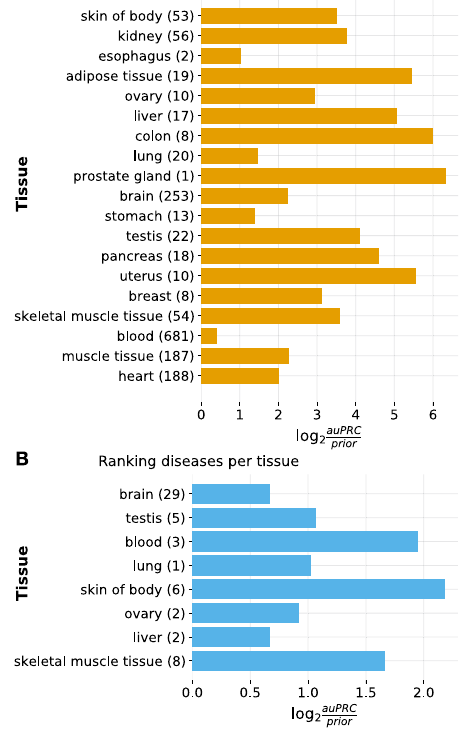
Fig. 5 | NLP-ML models can correctly classify tissue-associated biological pro- cessesanddiseasesbasedontheirtextdescriptions.A Modelperformancesona set of manually curated tissue-speci fi c Gene Ontology biological process (GOBP) terms 30 . B Modelperformancesonasetofmanuallycuratedtissue-speci fi cDisease Ontologyterms 30 .Inbothpanels,Themodelsareindicatedalongthe y -axiswiththe number of annotated GOBP/DO terms in parentheses next to the tissue name. Performance is shown on the x -axis using the logarithm of the area under the precision-recall curve (auPRC) over the prior, where the prior is the fraction of all GOBP/DOtermsspeci fi ctoaparticulartissue.Thismetricaccountsforthevariable number of annotated terms per tissue. Source data are provided as a Source Data fi